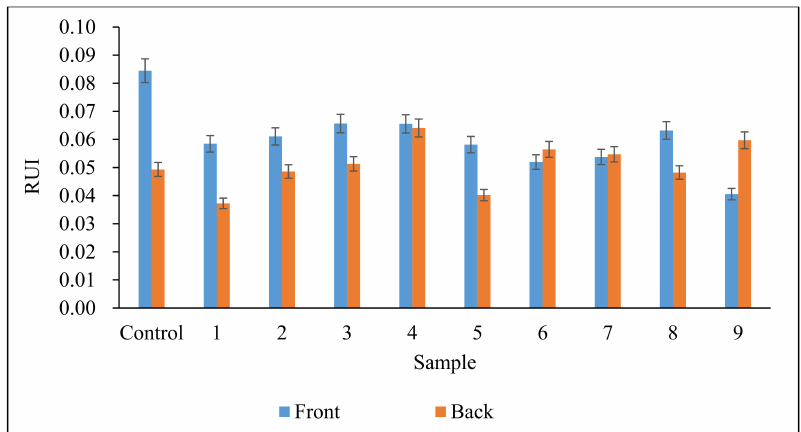
Figure 2. Relative unlevelness index (RUI) of 1 g/L pigment-dyed cotton samples (Front: atmospheric pressure plasma-treated fabric side; Back: non-atmospheric pressure plasma-treated fabric